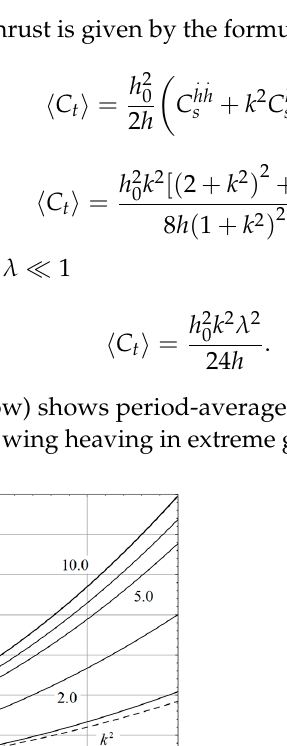
Figure 9. Period-averaged thrust coefficient for a flat rectangular wing of different aspect ratios λ in heaving oscillations versus Strouhal numbers.